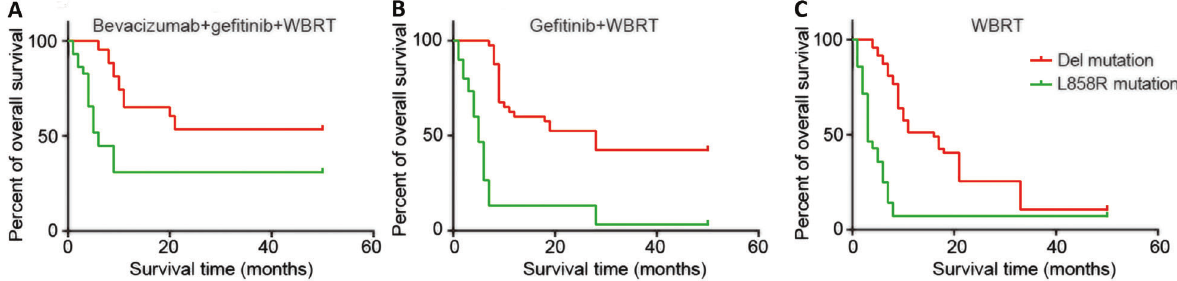
Figure 3. Kaplan-Meier estimation of overall survival rate in patients with brain metastases due to non-small-cell lung cancer with and without EFGR mutations treated with bevacizumab-ge fi tinib-WBRT, ge fi tinib-WBRT and WBRT. WBRT: whole brain radiotherapy.